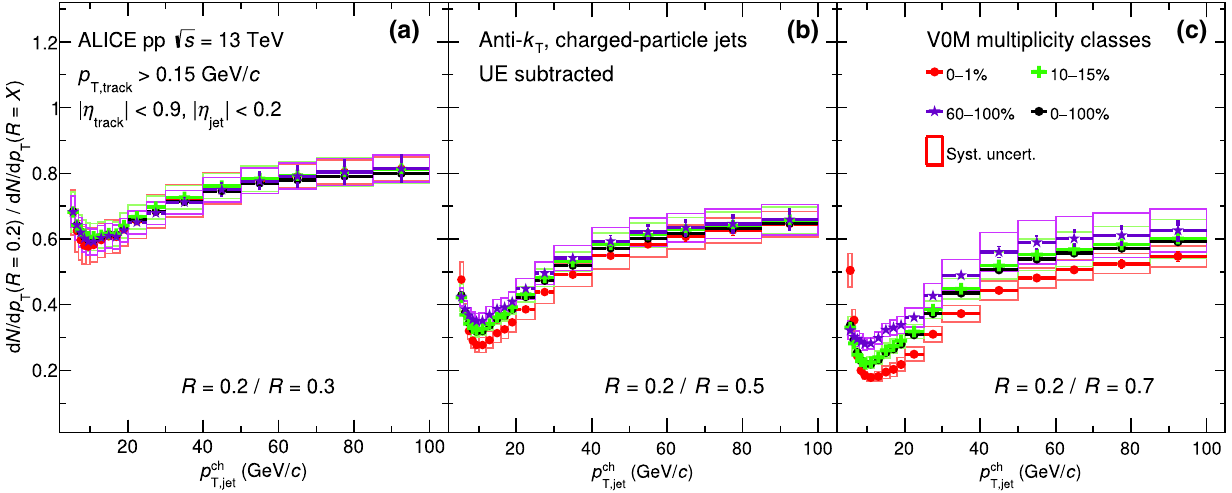
Fig. 10 Comparison of jet spectra ratios of R = 0 . 2 to other radii R = 0 . 3 (a) , 0 . 5 (b) , 0 . 7 (c) in MB events and in three multiplic- ity intervals (0–1%, 10–15% and 60–100%). Statistical and systematic